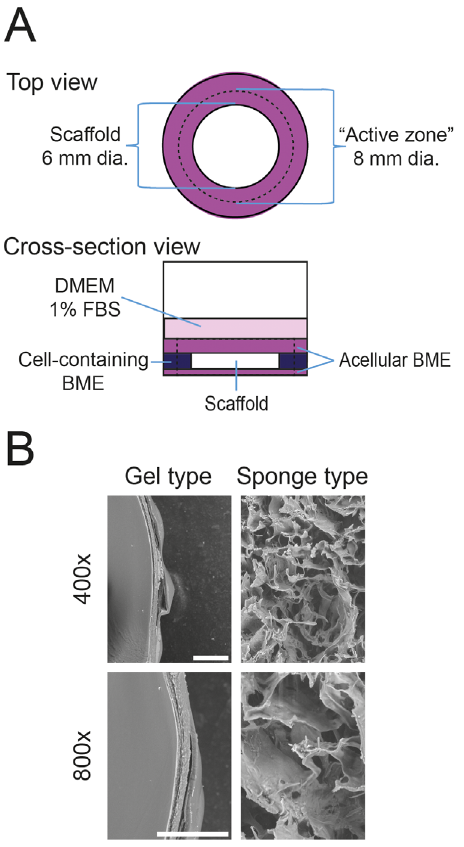
Figure 1. Exvivo wound healing model and scaffold properties. The ex vivo wound healing model is shown in top view and cross- sectional view (A). The bottom of the well was covered with an acellular growth factor reduced basal membrane extract (BME). The scaffold (sponge type scaffold composed of cross-linked collagen or the gel type scaffold composed of rat collagen I) in the center was surrounded by a BME-gel containing 800,000 hGFs/ml and covered with an acellular BME gel and Dulbecco’s Modified Eagle’s Medium (DMEM) supplemented with 1% fetal bovine serum (FBS) and antibiotics. Both scaffold and gel were tested with and without the addition of platelet-derived growth factor-BB (PDGF). Fluorescence images were taken to assess DiI-labeled cells within the scaffold over time. To assess the metabolic activity and gene expression dynamics, the scaffolds including the ‘‘active zone’’ (dashed line) were subjected to MTT tests, gene array analysis, and quantitative PCR. (B) Representative scanning electron microscopy images depict the morphology of the collagen gel, collagen scaffold at 400 6 , and 800 6 magnification. The white bar represents 100 m m. doi:10.1371/journal.pone.0112680.g001 which surrounded the scaffolds (See Fig 1) and transferred to reaction tubes. By punching out the scaffold and the ‘‘active zone’’ we included the cells in the perimeter of the scaffold. This is in line with the setup of other ex vivo wound healing studies [23]. 300 m L isopropanol was added and formazan crystals were solubilized by vortexing for 30 sec. Absorption of 100 m L was measured in a Multiskan Ascent microplate reader (Thermo Labsystems, Wal- tham, MA, USA) at 560 nm with a 650 nm correction. For the endpoint measurement, eight sponge type scaffolds and seven gel type scaffolds were evaluated. For the time course experiment, six sponge type scaffolds and six gel type scaffolds were evaluated. The data are given as mean 6 standard deviation.